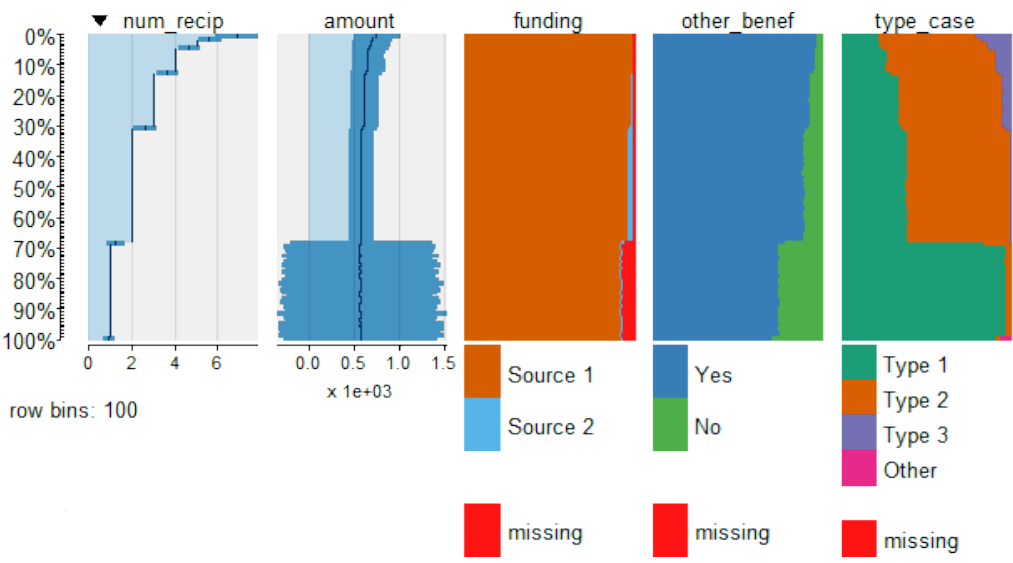
Figure 2: Example letter-value plots for simulated data